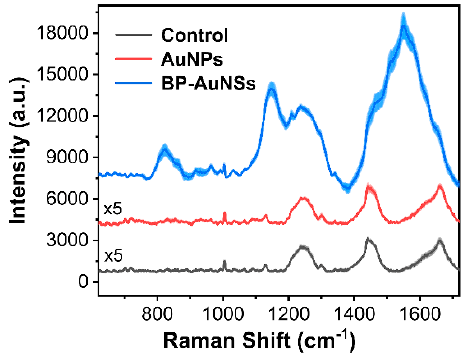
Figure 3. ( a ) Full-scale label-free SERS imaging of mouse brain section. ( b – d ) Raw Raman spectral lines collected from five pixel points in the brain sections treated without ( b ) or with nanostructures (AuNPs ( c ) and BP-AuNSs ( d )).